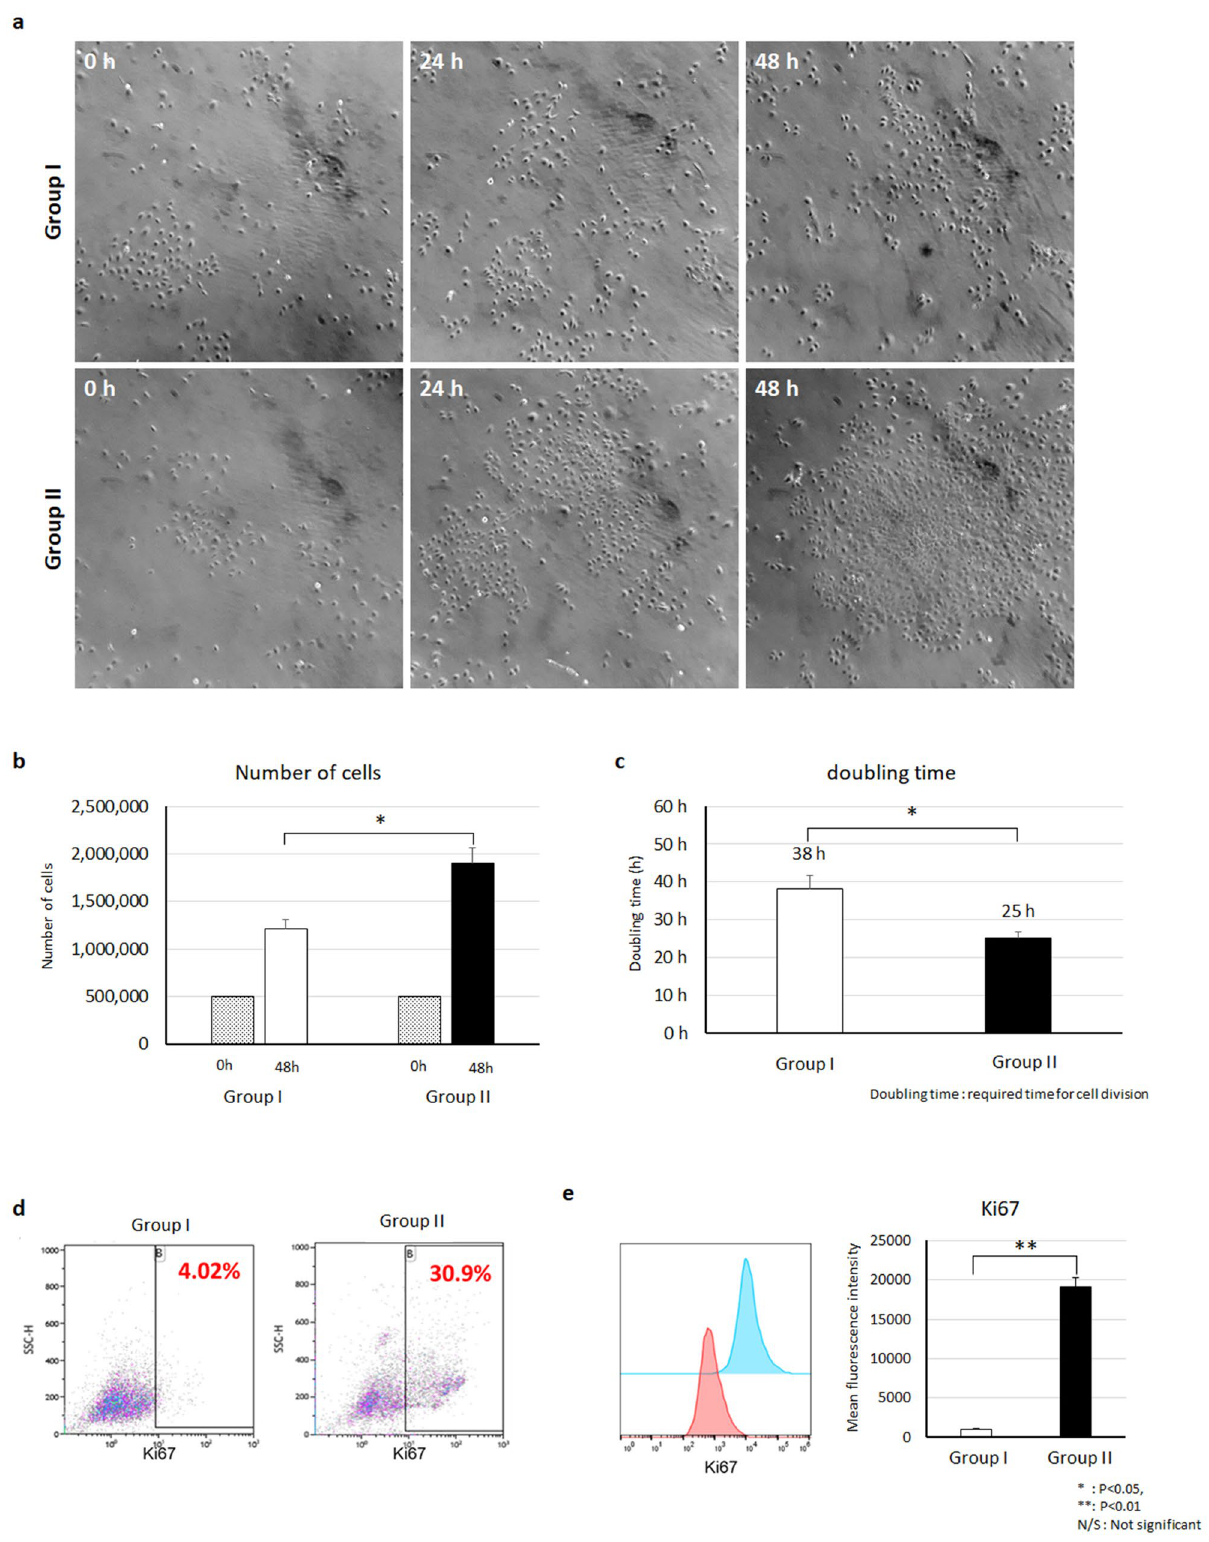
Figure 2. hMSC CM stimulates the proliferation of human granuloma cells. ( a ) Morphology and population changes of HGrC1 within 48 h. ( b ) Cell numbers of control HGrC1 (Group I) and MSC CM-treated HGrC1 (Group II). ( c ) Doubling times of control HGrC1 (Group I) and MSC CM-treated HGrC1 (Group II). ( d – e ) Flow cytometry analysis of the proliferation marker Ki67 in control HGrC1 (Group I) and MSC CM-treated HGrC1 (Group II). Two biological replicates per group were analyzed in duplicate (* P < 0.05, ** P < 0.01, N/S not